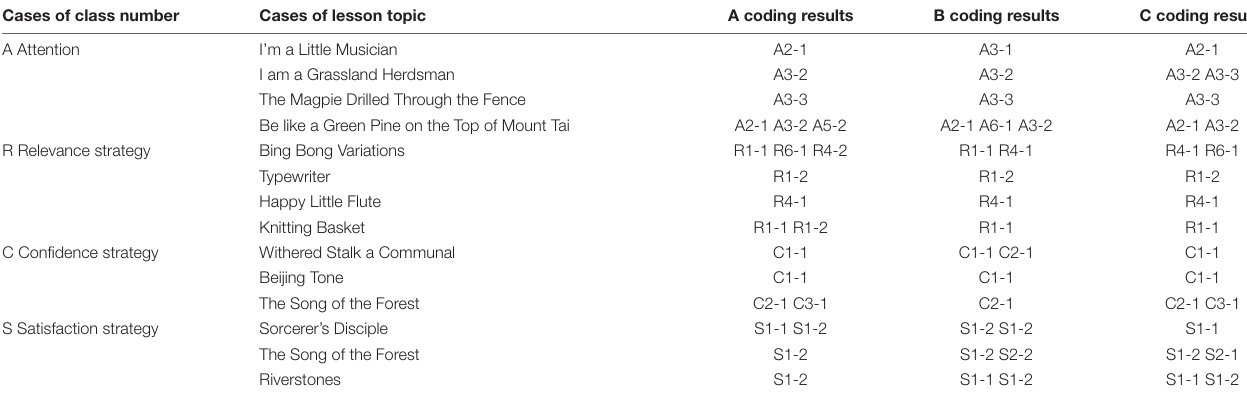
TABLE 6 | Test data of attention, relevance, confidence, and satisfaction (ARCS) motivation model after optimization. Cases of class